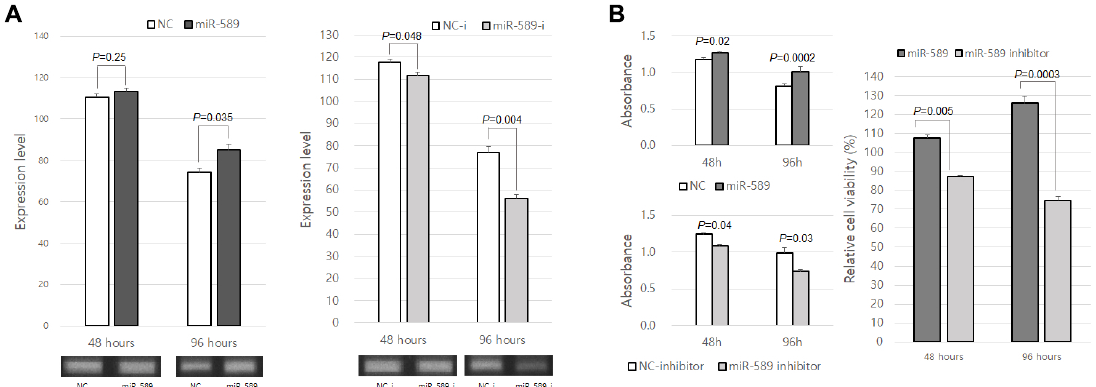
Figure 6. Effects of miR-589 on Hep-2 cells. The cells were transfected with miR-589, miR-589 inhibitor, and their negative controls. ( A ) Expression levels of miR-589 in the cells transfected with miR-589, miR-589 inhibitor, or their negative controls at 48 and 96 h. These are measured by RT-PCR, and 48 and 96 h were examined on different gels. Uncropped images of gels are shown in Figure S4. ( B ) Cell viability and proliferation rate. The transfected cells were measured by MTT assay at different time periods. The averages of three independent MTT assays performed in triplicate are shown with standard error (SE) bars. The p -values of miR-589 versus its normal control, miR-589 inhibitor versus its normal control, and miR-589 versus miR-589 inhibitor were calculated by using two-tailed t